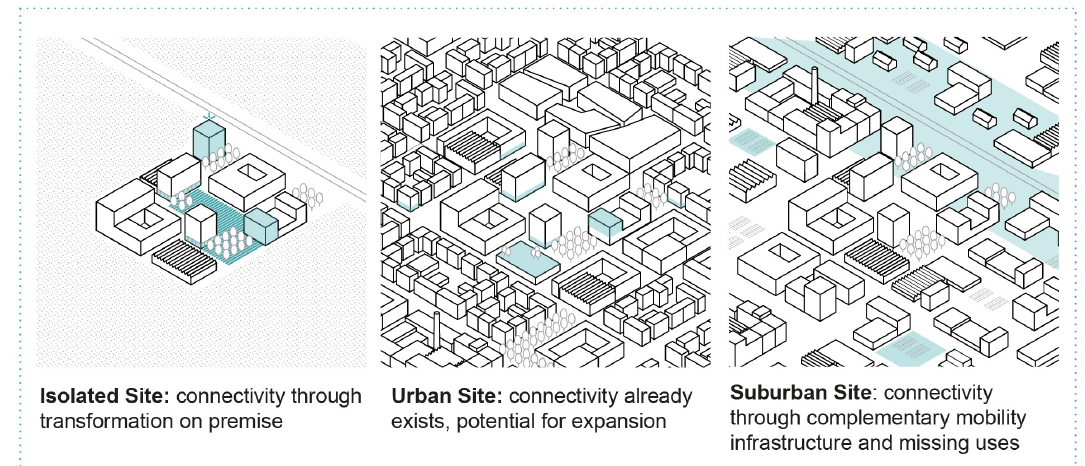
Figure 6. Company sites and potential for connectivity (marked in green; see descriptions in Subsections